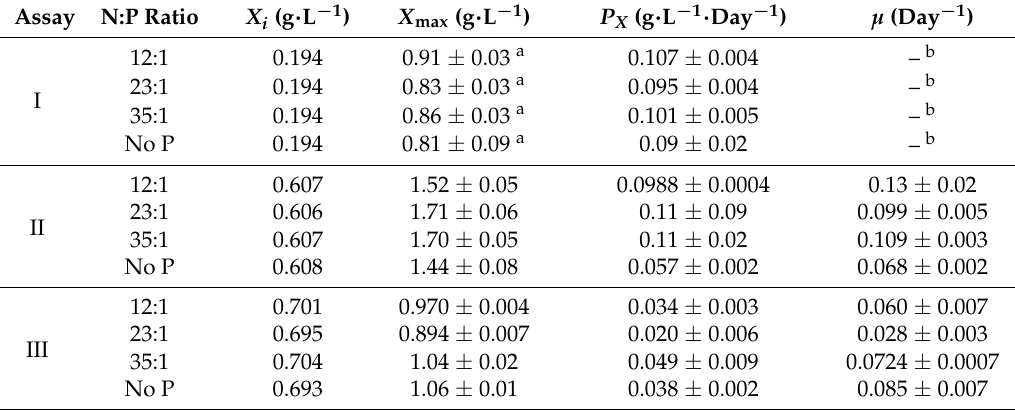
Table 1. Biomass production parameters determined for assays I, II and III under different N:P ratios.